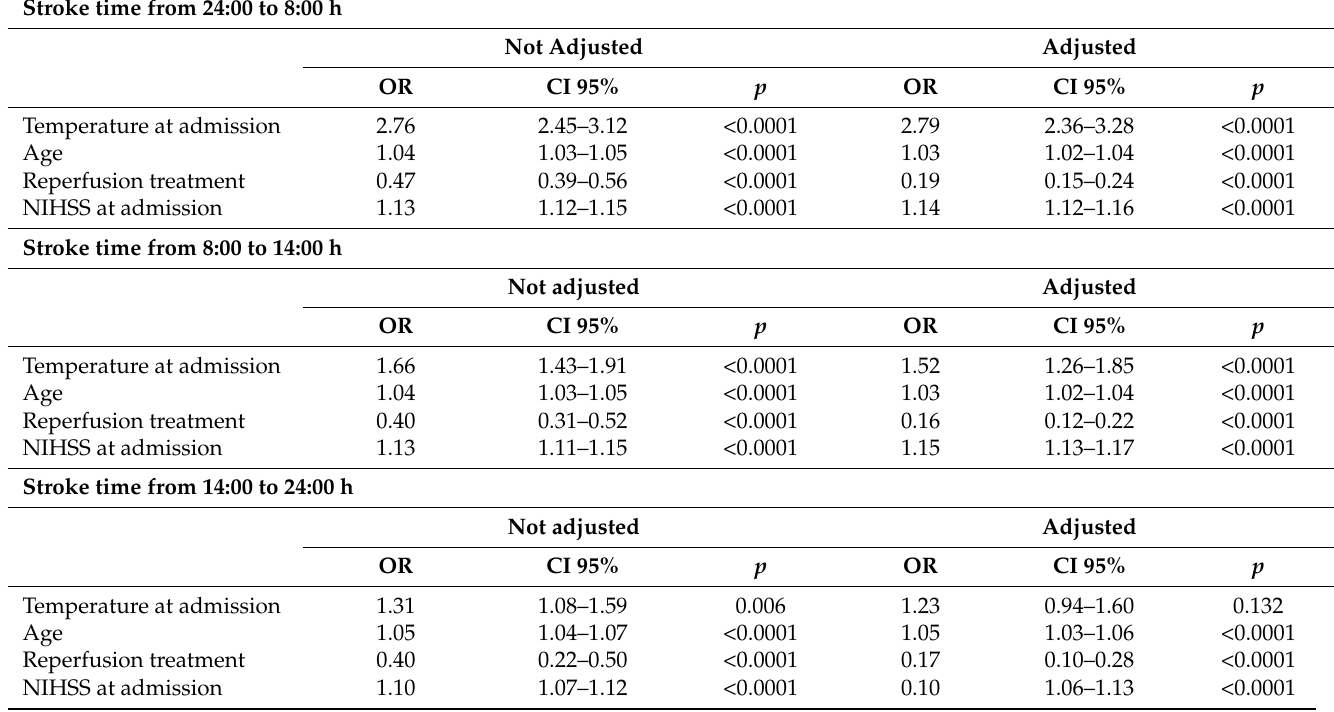
Table 1. Logistic regression model for temperature and NIHSS at admission, age, and reperfusion treatment. Dependent variable: poor outcome at 3